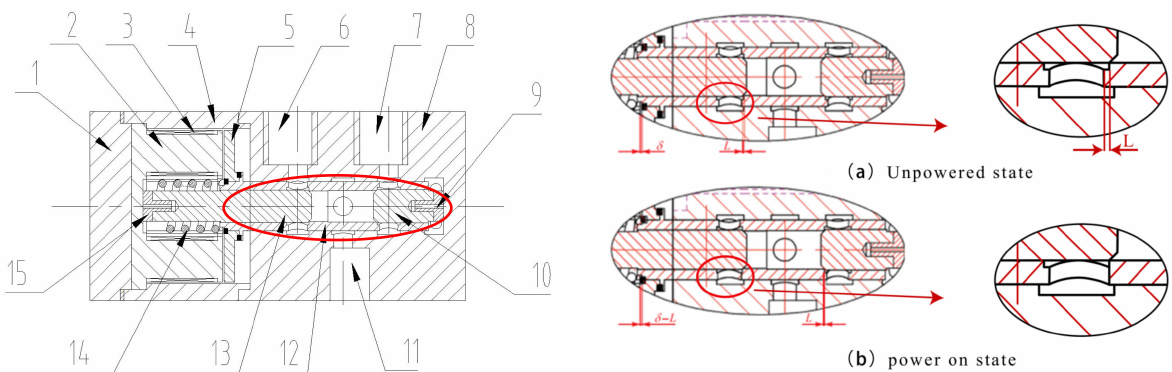
Figure 2. The structure of solenoid valve and solenoid valve in on and off working state. 1—Valve cover; 2—Static core; 3—Valve housing; 4—coil; 5—Armature; 6—Oil inlet; 7—Oil return port; 8—valve body; 9—Right cushion block; 10—Right cone valve element; 11—Control port; 12—Outer valve core; 13—Left cone valve element; 14—Return spring; 15—Left cushion